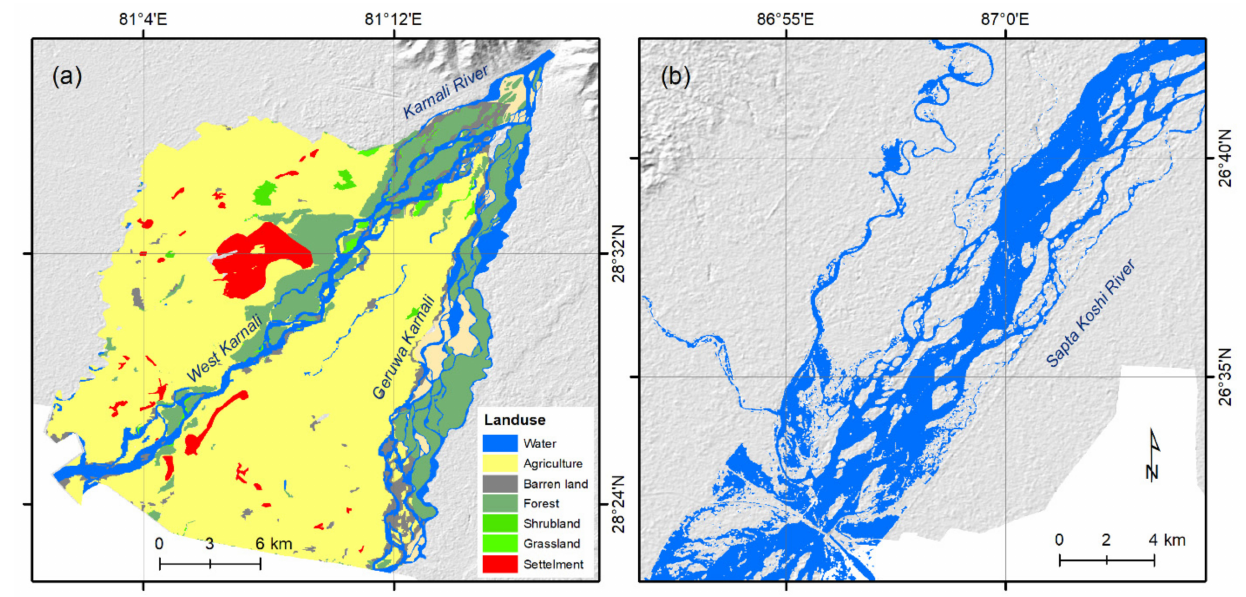
Figure 4. Mapping of flood extent using open source Optical and Radar data, prepared by Authors as examples in this study: ( a ) Flood extent and land use mapping of the lower Karnali River using Optical imagery of Sentinel 2A of 12 October 2019 and ( b ) Flood mapping of the Koshi River of Nepal using Sentinel-1 SAR data of 12 July 2020 (summer monsoon) as an example. Background represents the hillshade from the ASTER GDEM. The optical data during the monsoon are rarely usable as they are affected by the cloud cover; the SAR data can be the best choice to overcome such issues. Table 4. Geographic open and public data sources in Nepal and their